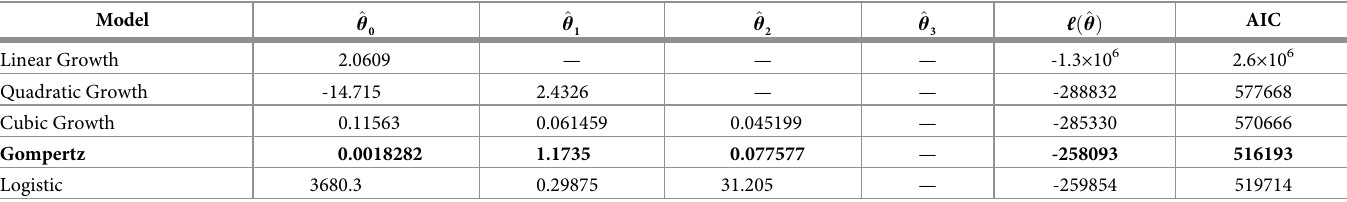
Table 6. Fetal mass models (mass in g vs. gestational age in